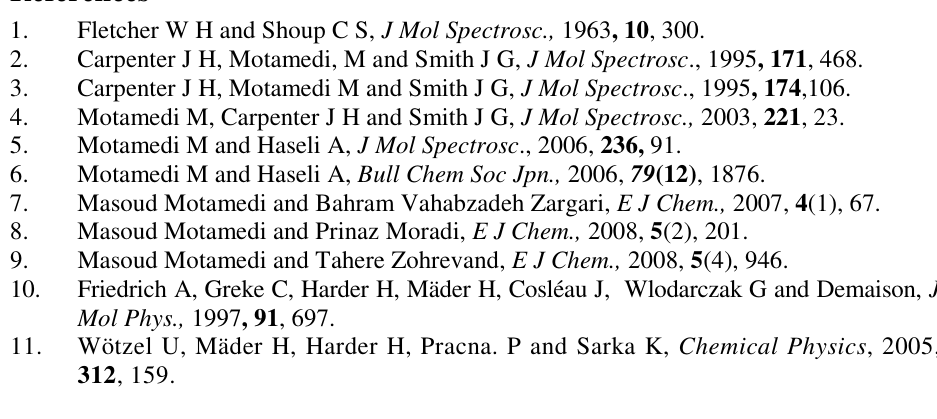
in ground state for J = 3